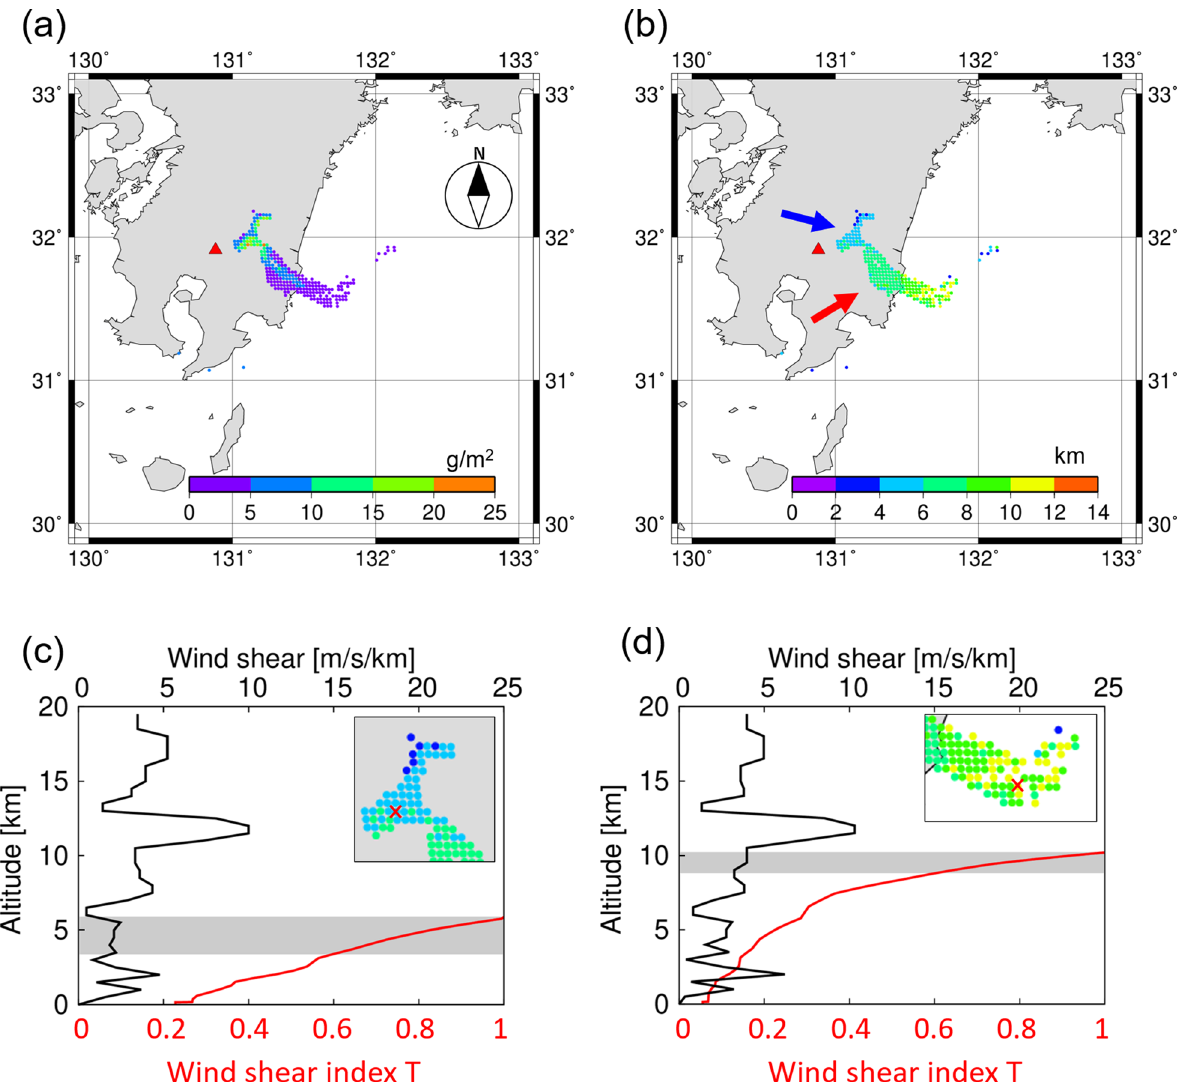
Fig. 1 OVAA outputs at 20:30 on April 4, 2018 (UTC), the wind shear strength | d v | / dz , and the wind shear index. a The total column mass loadings estimated by OVAA. b The top heights estimated by OVAA. The blue arrow shows the ash cloud from the first eruption (18:31UTC), and the red arrow shows the ash cloud from the second eruption (18:45UTC). c Wind shear strength (black line), wind shear index (red line), and estimated ash cloud layer (grey) for Tc 0.6 at N31.970/E131.128 (red cross mark in inset). d Same as c , but for N31.516/E131.733. The red triangles show the = location of the Shinmoedake